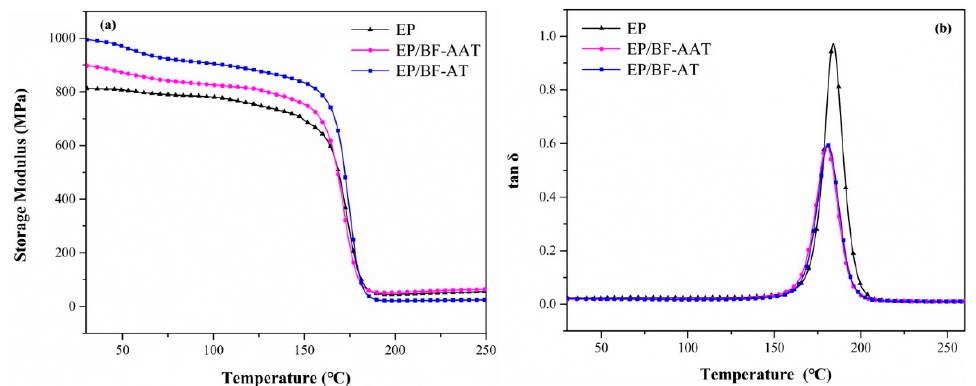
Figure 4. Dynamic mechanical thermal behavior of epoxy-based hybrid composites: ( a ) Plots of storage modulus versus temperature; ( b ) plots of tan delta versus temperature.